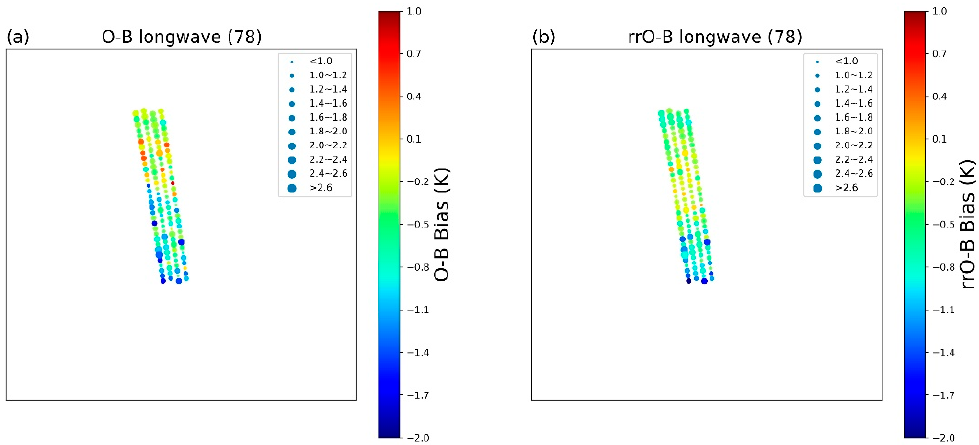
Figure 14. ( a ) Average array distribution characteristics of the background departures (O-B) of channel 78 during typhoon Mangkhut; and ( b ) average array distribution characteristics of the reconstructed background departures (rrO-B) of channel 78 during typhoon Mangkhut.